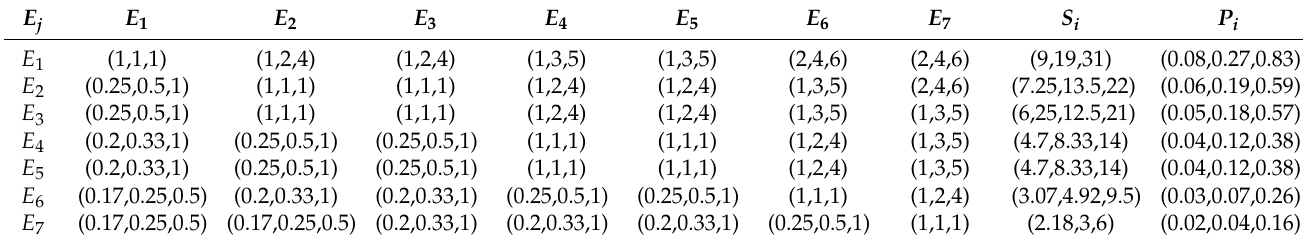
Table 3. Fuzzy judgment matrix and fuzzy synthetic extent of exposure indicators.